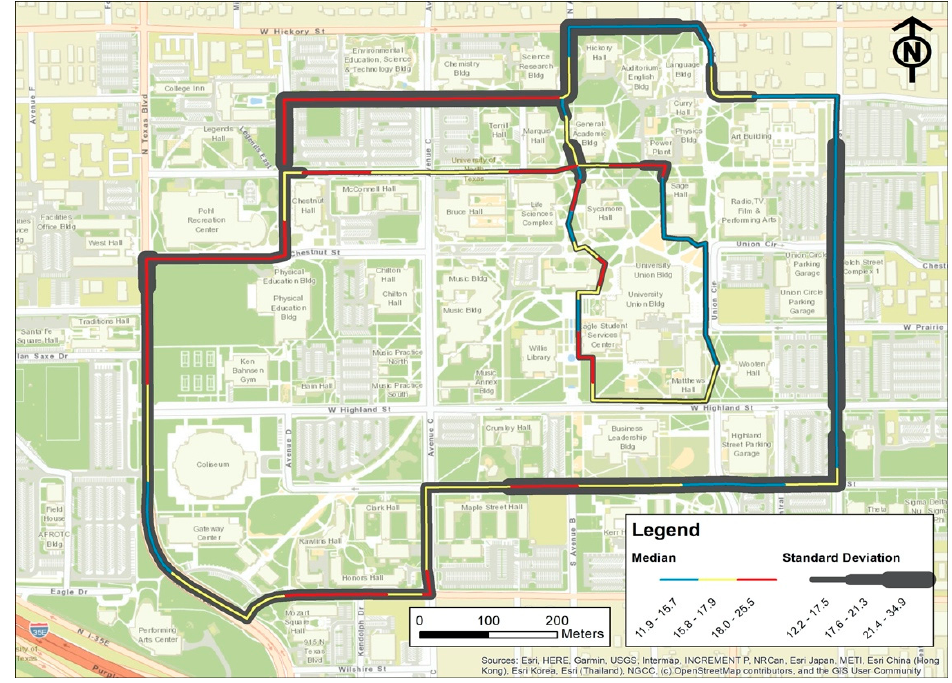
Figure 7. The average and standard deviation of PM 2.5 concentration (µg/m 3 ) during the survey period for each route segment. Colors indicate the mean, and the gray buffer around the lines indicate the range of standard deviation.